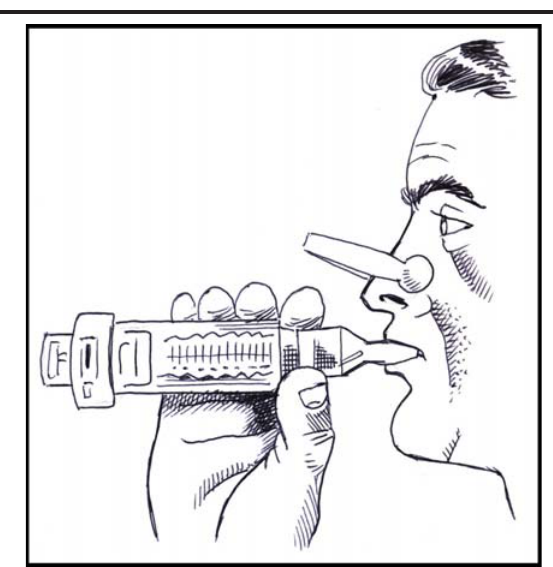
FIGURE 4 - Schematic drawing of utilization of Threshold